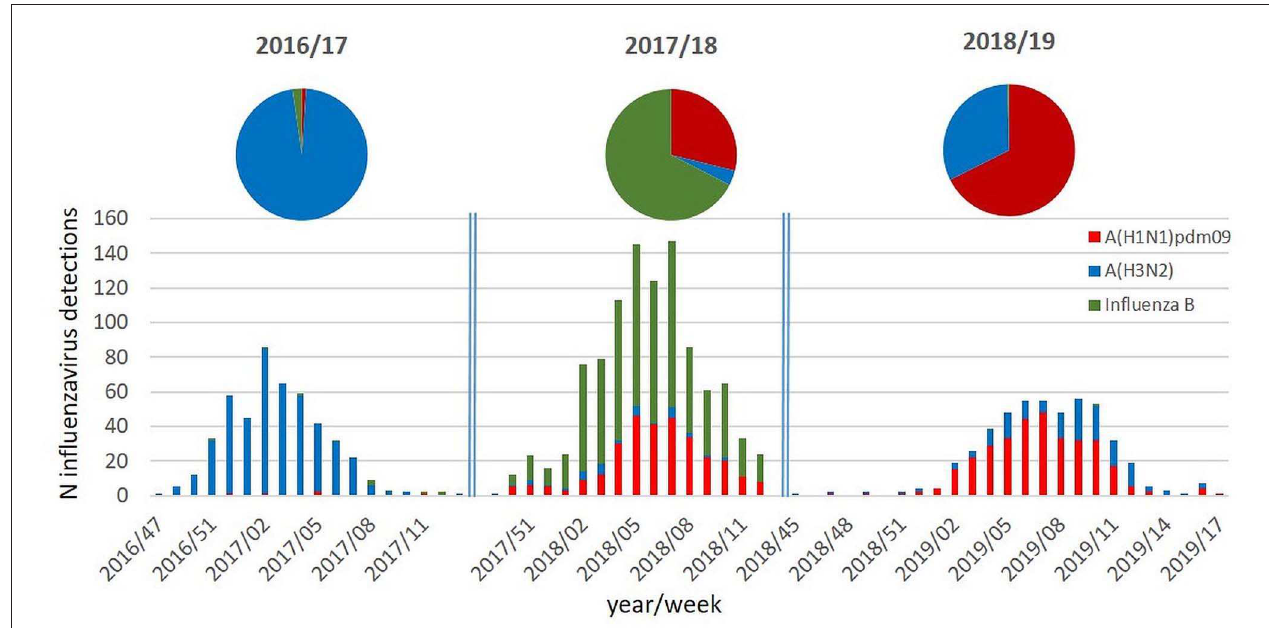
FIGURE 1 | Columns: number of influenza virus detections per week and per type/subtype during the influenza seasons 2016/17 to 2018/19; pie chart: proportion (%) of the circulating influenza virus types/subtypes during the respective influenza seasons.